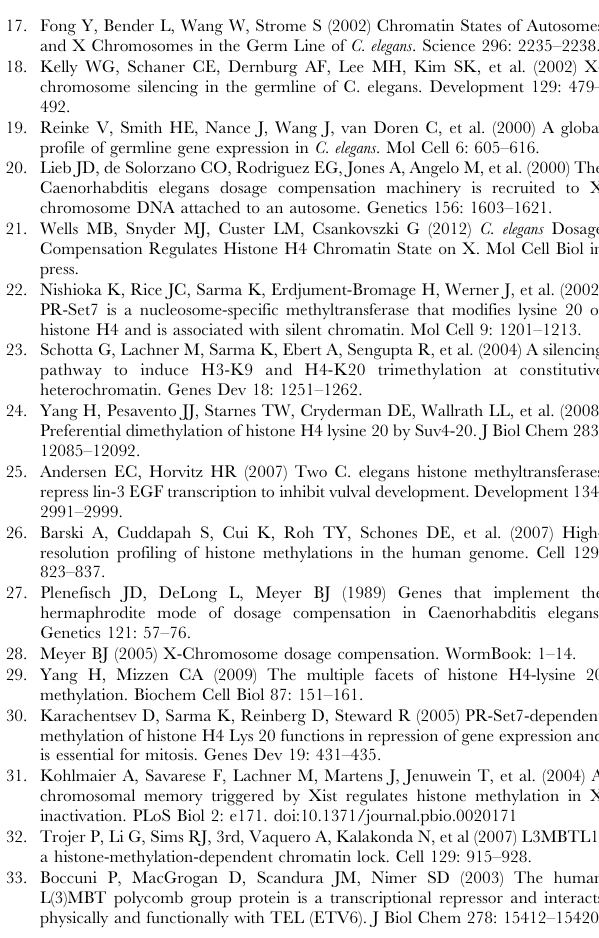
DPY-27, shows lower staining of both modifications than other regions. In dpy-21 mutants, this difference is not observed. Figure S6 Enrichment of H4K20me1 on X is abolished in set-4 mutants. (A) Genome browser tracks of H4K20me1 ChIP-seq signals across representative regions of chromosome I and chromosome X in wild-type (WT) and set-4 mutant L3 larvae. Signal is displayed as z-scores (standardized log 2 ratios of ChIP/ Input signals). Enrichment of H4K20me1 on X is lost in set-4 mutants. (B) Plots of H4K20me1 signal across the TSS (transcript start site) and TES (transcript end site) of genes on X (red) and autosomes (blue). Genes in the top 20% of expression (dark shades) and bottom 20% (light shades) are plotted separately. (C) Plots of H4K20me1 signal centered at intergenic regions at least 5kb from any annotated feature. (D) Box plots of overall H4K20me1 signals on each chromosome. Each box shows the median and extends from the 25 th to the 75 th percentile of the z-scores in the set; whiskers extending from the box indicate the 2.5 th and 97.5 th percentiles. Figure S7 Consistency of different H4K20me1 antibodies in ChIP. (A) Correlation between ChIP-chip signals using antibodies to H4K20me1 from Abcam and Diagenode (r= 0.95). (B) Plots of H4K20me1 signal across the TSS (transcript start site) and TES (transcript end site) of genes on X (red) and autosomes (blue). Genes in the top 20% of expression (dark shades) and bottom 20%